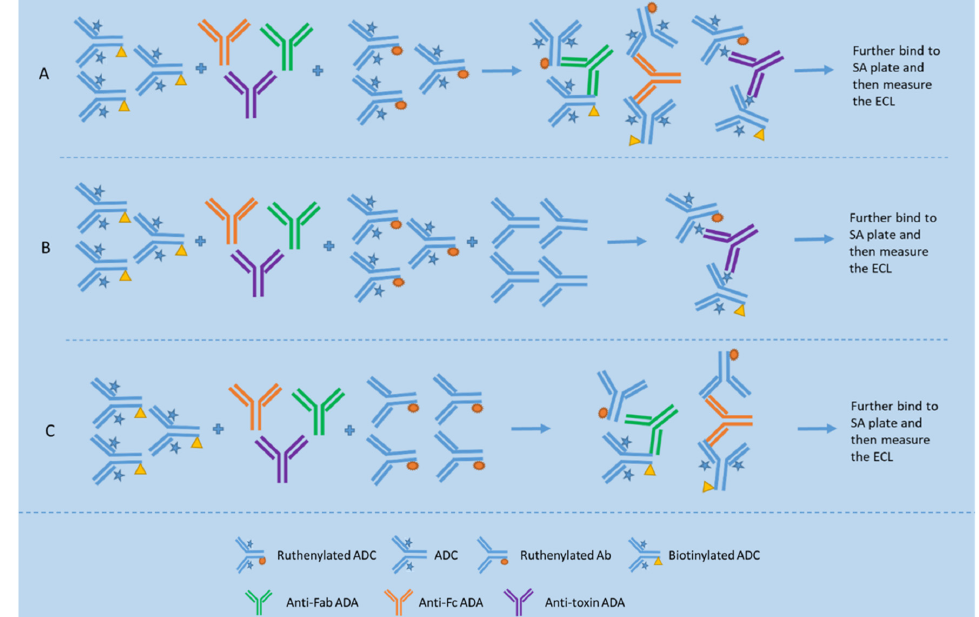
Figure 3. Bridging assay format for total ADA detection and two assay formats, namely epitope competition method and epitope detection method for domain specificity testing. ( A ) shows a typical bridging format for detection of ADAs against epitopes located on different portions of the ADC; ( B ) shows the epitope competition method used for detection of ADAs reactive with the antibody portion of the ADC based on the inhibition signal obtained when compared to the signal of the assay depicted in Figure ( A ); ( C ) shows the epitope detection method used for detection of ADAs reactive with the antibody portion of the ADC based on the specific binding signal obtained.